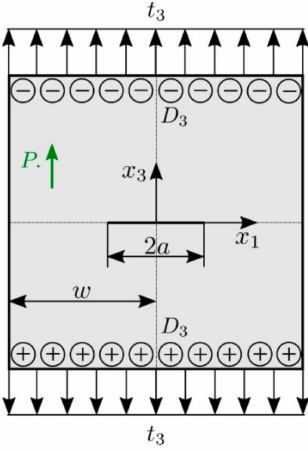
Figure 4. Crack in a square plate under an electro-mechanical loading.